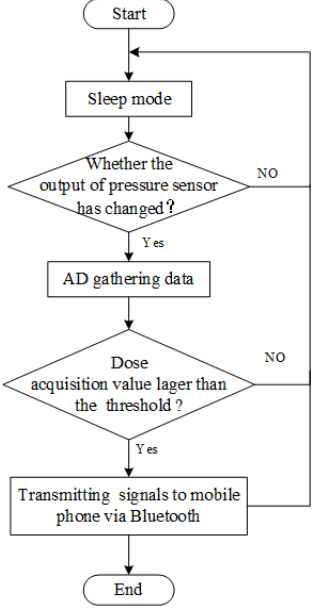
Figure 3. Flow chart of an intraoral sensor pressure detection system.